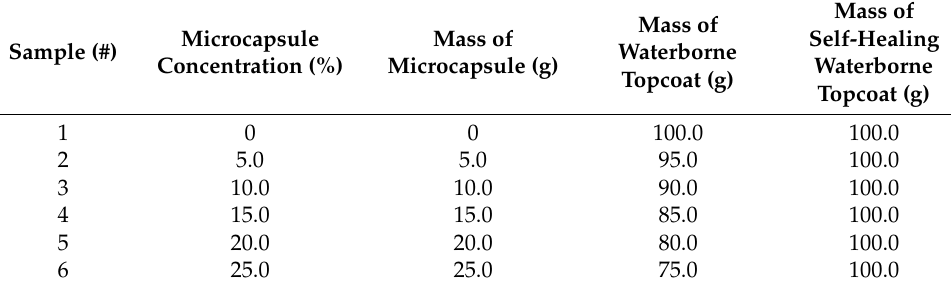
Table 3. Composition of self-healing waterborne